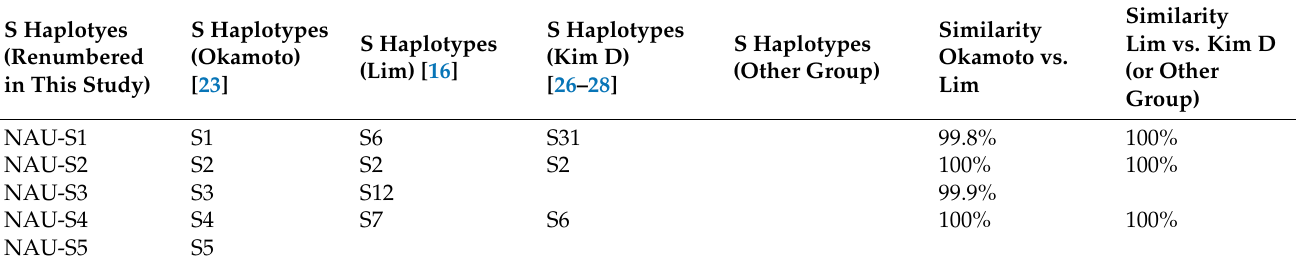
Table 1. Summary of S haplotypes in